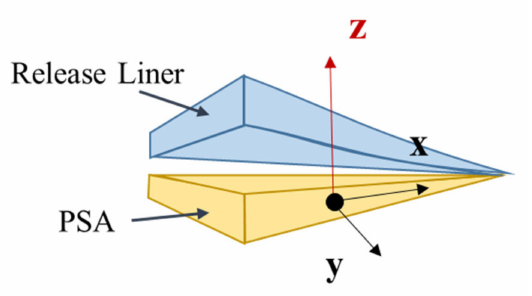
Figure 1. Schematic of single-layered PSA and loading